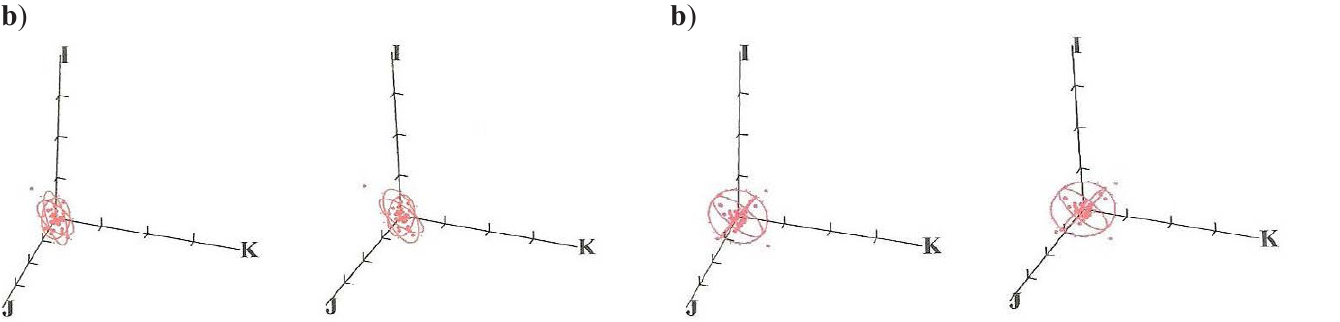
Figure 3: Stereo-pair scatter plots in symmetric dioptric power space for the anterior ( a ) and posterior ( b ) corneal keratometry for Subject 3.